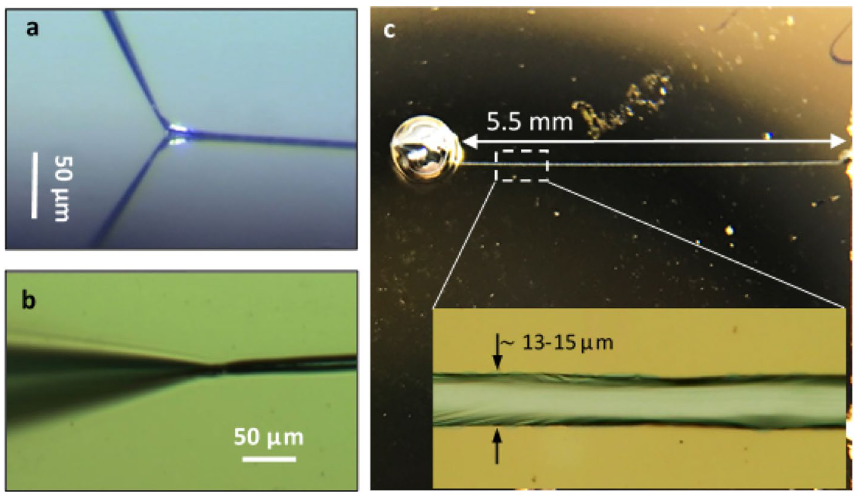
Figure 5. EGaIn on Au. ( a , b ) Optical images (side and top view, respectively) of the process of extrusion (under constant pressure, ~ 55 atm) of EGaIn on a gold surface. Once the initial droplet appears, the metal line that emerges is continuous. The entire deposition took ~ 10 min. See Supplementary Information S3 for a complete movie of the deposition. ( c ) Optical image of the completed pattern taken immediately after deposition. The inset is an optical image at higher resolution of the marked area in the main image, taken directly after patterning, showing a very clean deposition with sharp boundaries. Line width is 13–15 µm.